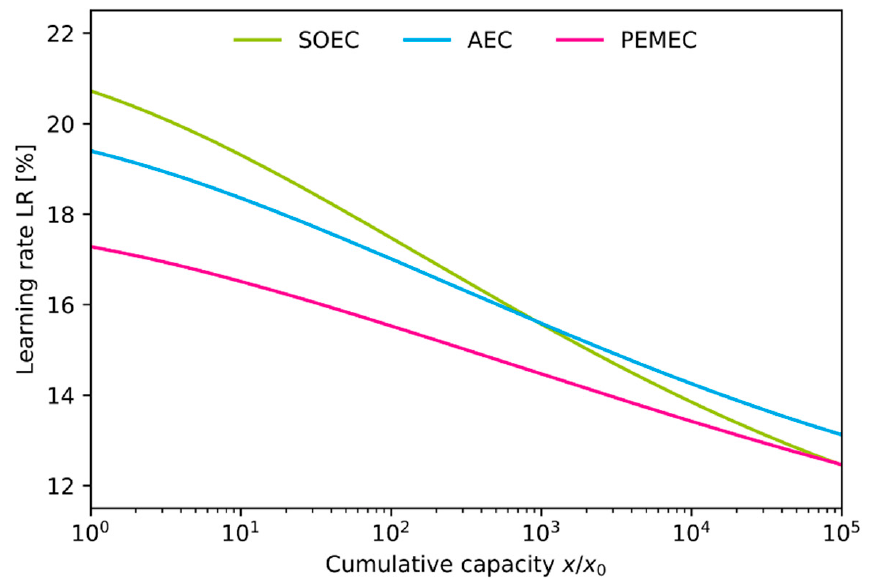
Figure 3. Diminishing learning rates for electrolyzer stacks as a function of capacity. Reproduced with permission from Böhm et al. [19].